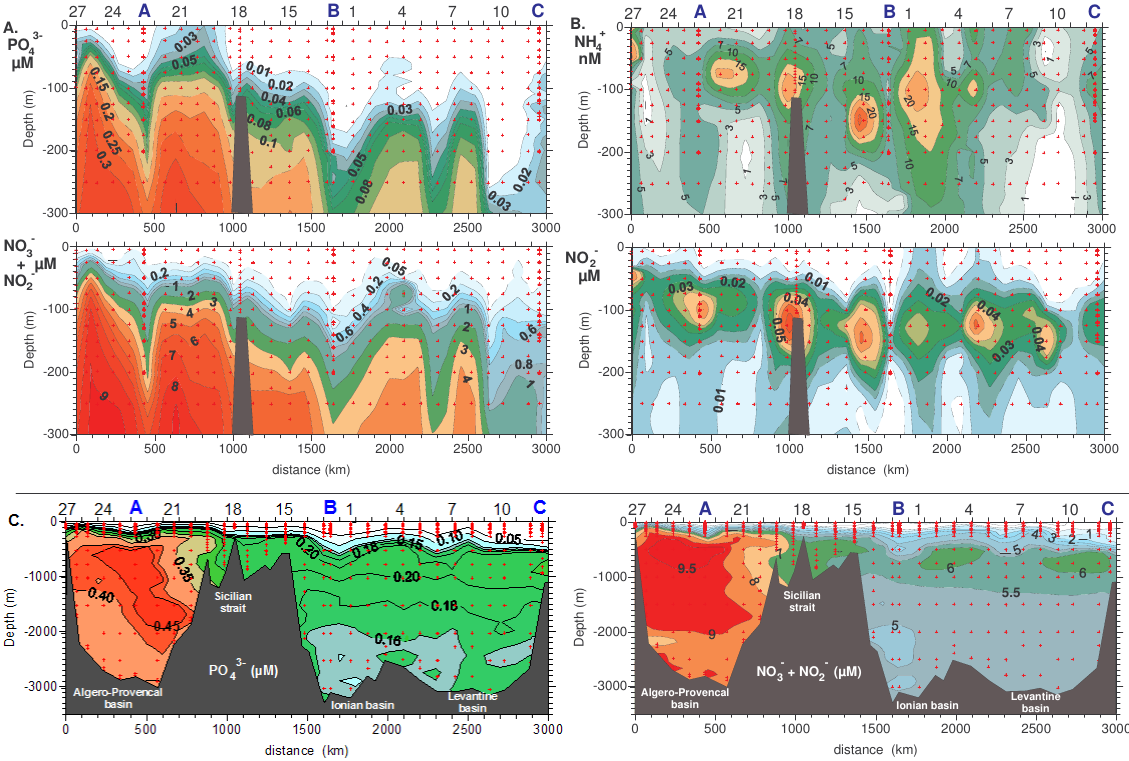
) , nitrate+nitrite (NO − ) , and (B) ammonium (NH + +NO − 4 3 2